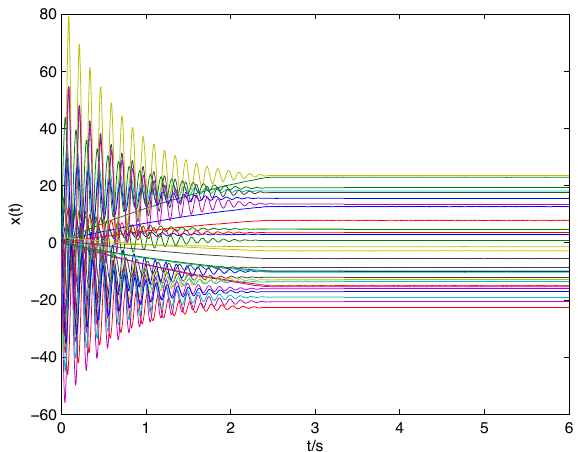
Fig. 2 The response curves of nodes’ state tracking error ¯ x